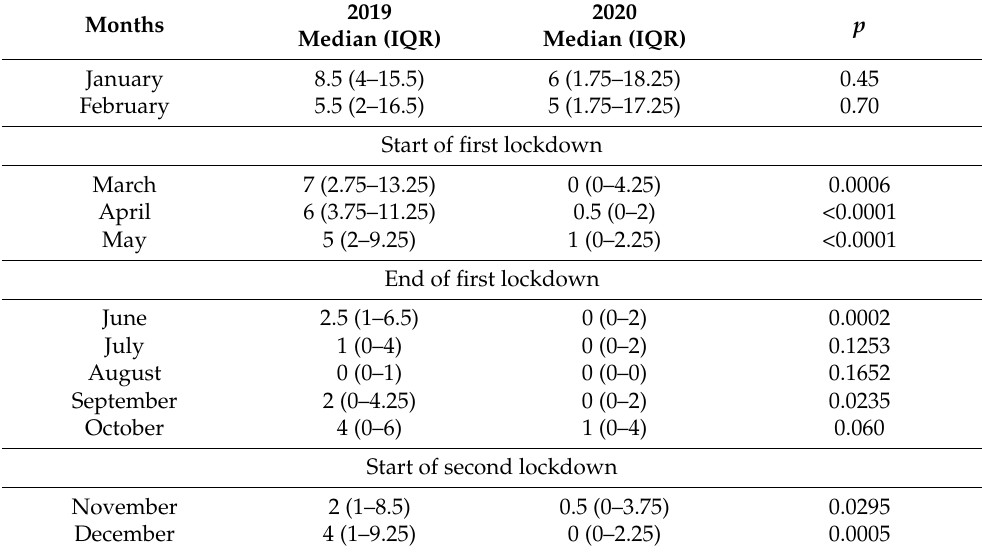
Table 2. Number of patients with asthma recorded monthly in 2019 compared to 2020, in the study population of 35,787 children aged 0–14